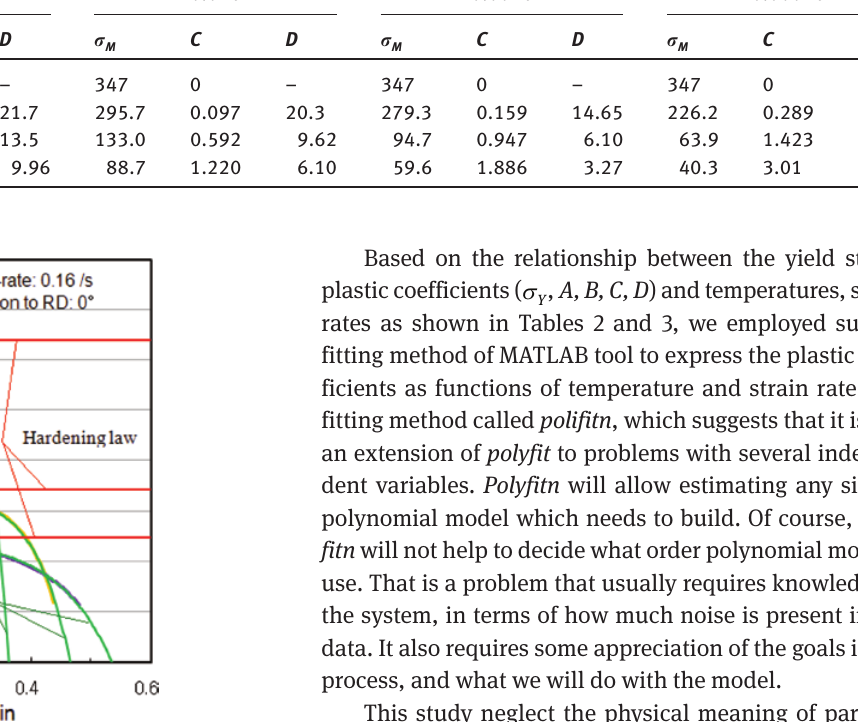
Figure 3 depicts the stress-strain fitting curves calcu- lated from Eq. (3) and experimental data at various ele- vated temperatures and strain rates. The proposed equa- tion from the mergence of Voce’s work-hardening and softening law shows in good agreement at each tempera- ture and strain rate.